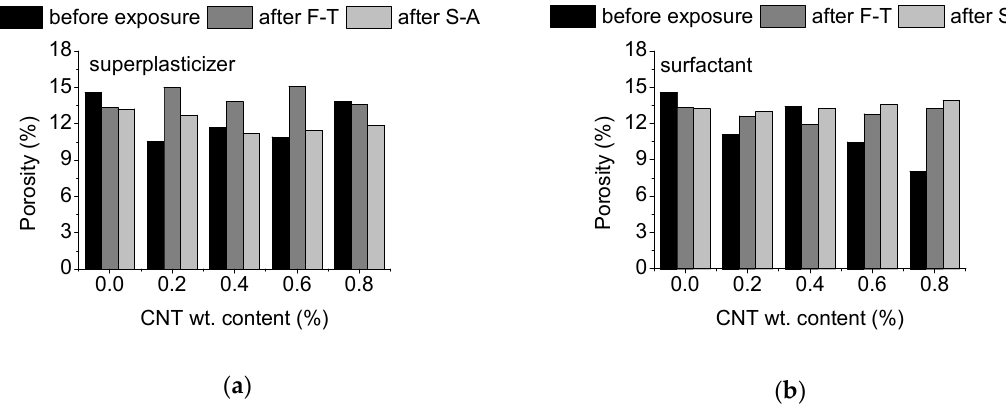
Figure 3. Effect of CNT content and exposure state on the porosity of mortars prepared using: ( a ) superplasticizer, and ( b ) surfactant as dispersant.